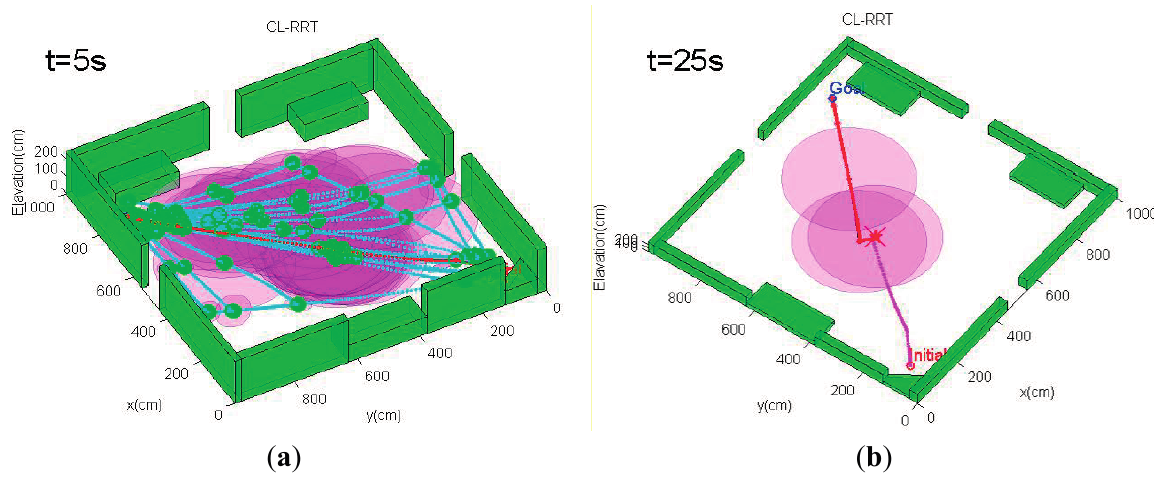
Figure 9. Example results of the trajectory generated by the conventional closed-loop rapidly exploring random trees (CL-RRT) for a quadrotor MAV navigating in simulation Scenario 1. The red cross in ( b ) denotes the state where the MAV’s state estimation fails, since the position uncertainty has become sufficiently high. ( a ) t = 5 s; ( b ) t = 25